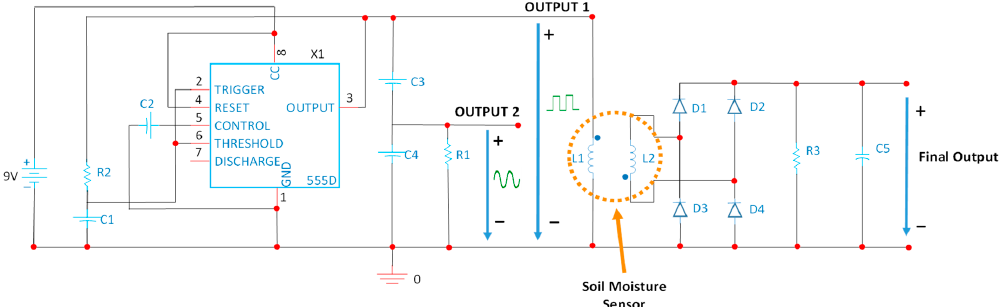
Figure 8. Enhanced power circuit schematic.